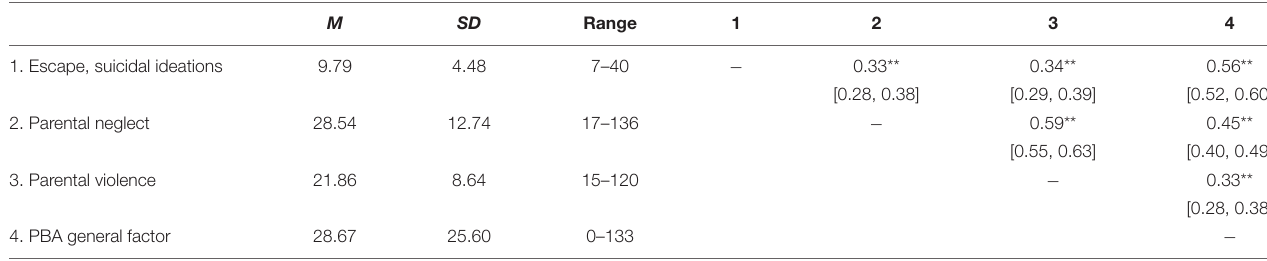
TABLE 7 | Means, standard deviations, and Pearson correlations with confidence intervals between PBA general factor and measures of escape and suicidal ideations, parental neglect, and parental violence toward one’s children. M SD